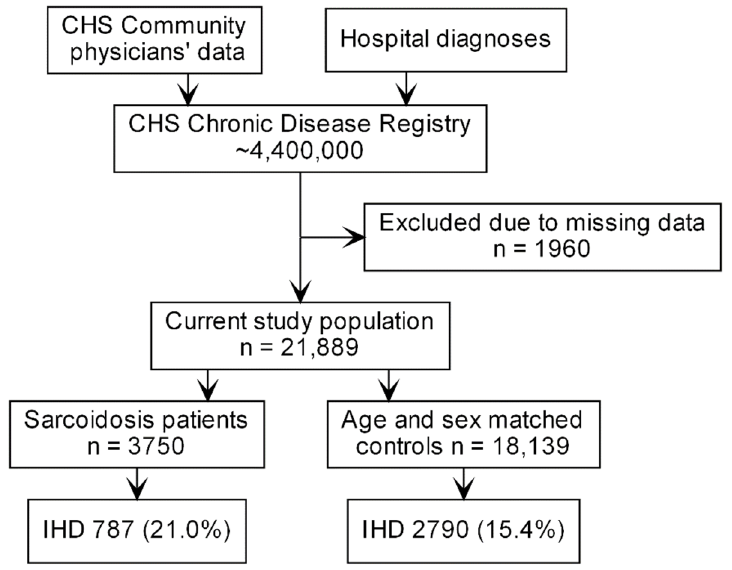
Figure 1. Study flowchart. CHS—Clalit Health Services, N—number of cases, IHD—ischemic heart disease. Table 1. Characteristics of the study population.